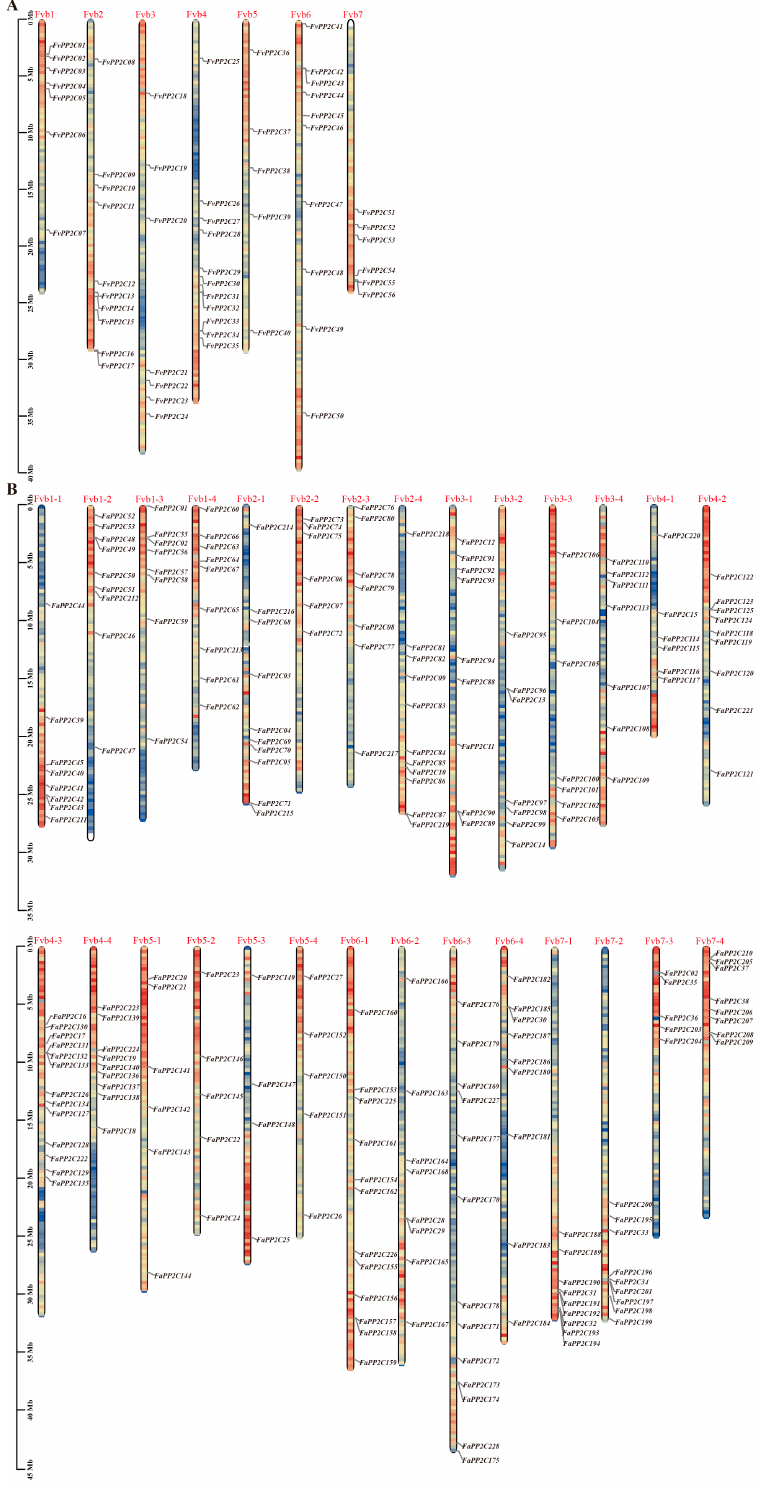
Figure 2. Chromosome distribution of the PP2C gene family in woodland strawberry and pineapple strawberry. Note: The left scale indicates the chromosome length (Mb), with PP2C gene markers on the right side of each chromosome. Different chromosomal colors indicate different gene densities, with red indicating the highest density and blue the lowest density. ( A ) Chromosome distribution of FvPP2Cs . ( B ) Chromosome distribution of FaPP2Cs